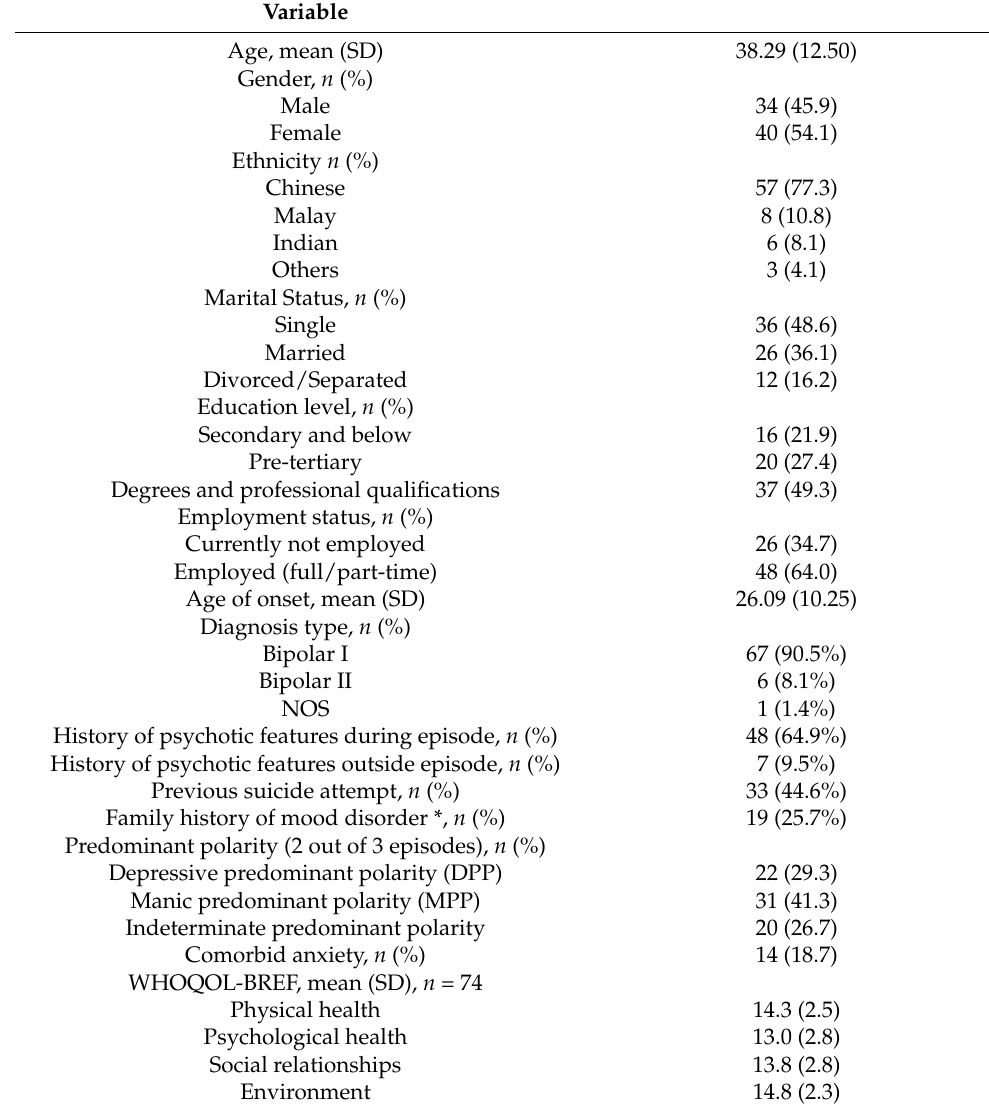
Table 1. Summary of sociodemographic, clinical and course-of-illness